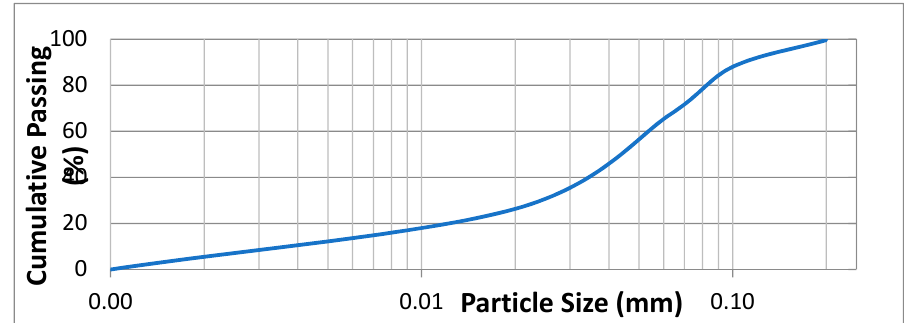
Figure 3. Sieve Analysis (Particle Size Distribution PSD) of olivine <200 µm.